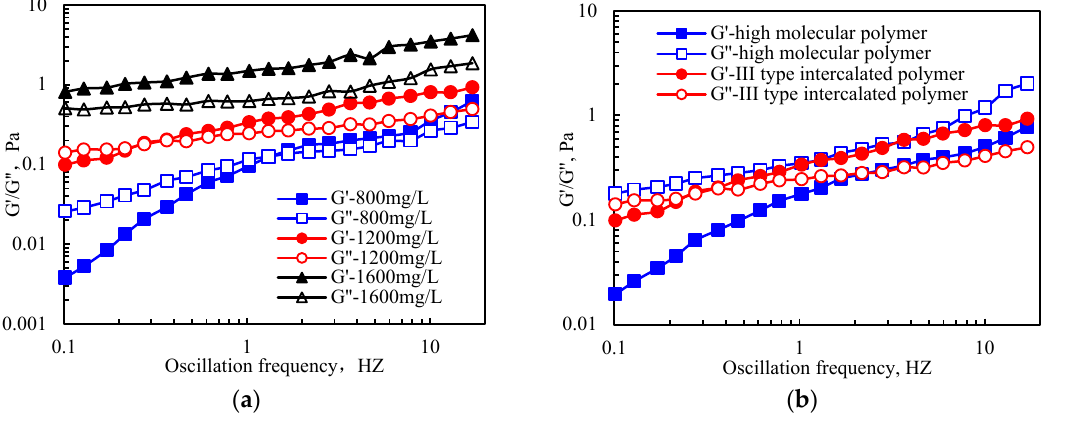
Figure 10. Viscoelasticity of the intercalated and high-molecular-weight polymers: ( a ) the III-type intercalated polymer of different concentrations; ( b ) 1200 mg/L III-type intercalated and high- molecular-weight polymers.